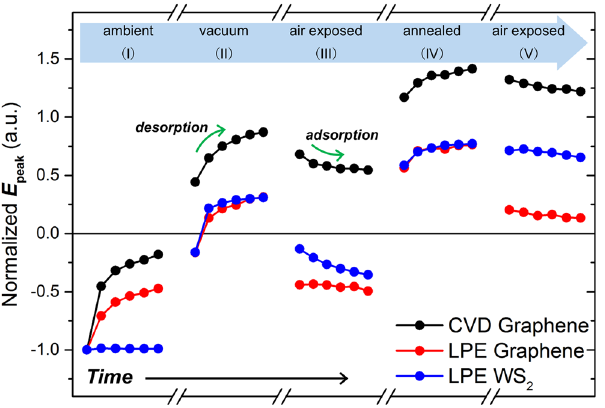
Figure 2. Temporal evolution of the THz peak amplitude at different conditions. The peak values (first peak at ~2 ps) are normalized with respect to the first peak of the initial THz emission measured in ambient conditions (I). The THz emission is recorded at 2-minute intervals after changing the environmental condition. Increase (decrease) in the peak value means net desorption